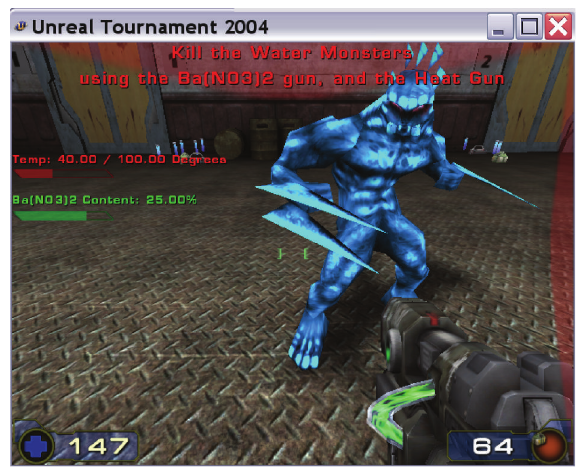
Figure 1: SolubilityFPS